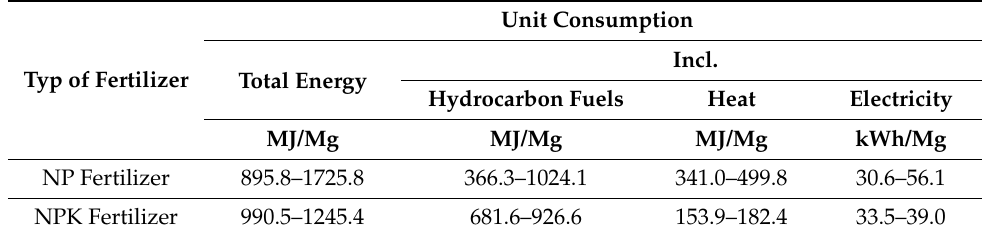
Table 3. Energy consumption of selected compound fertilizers